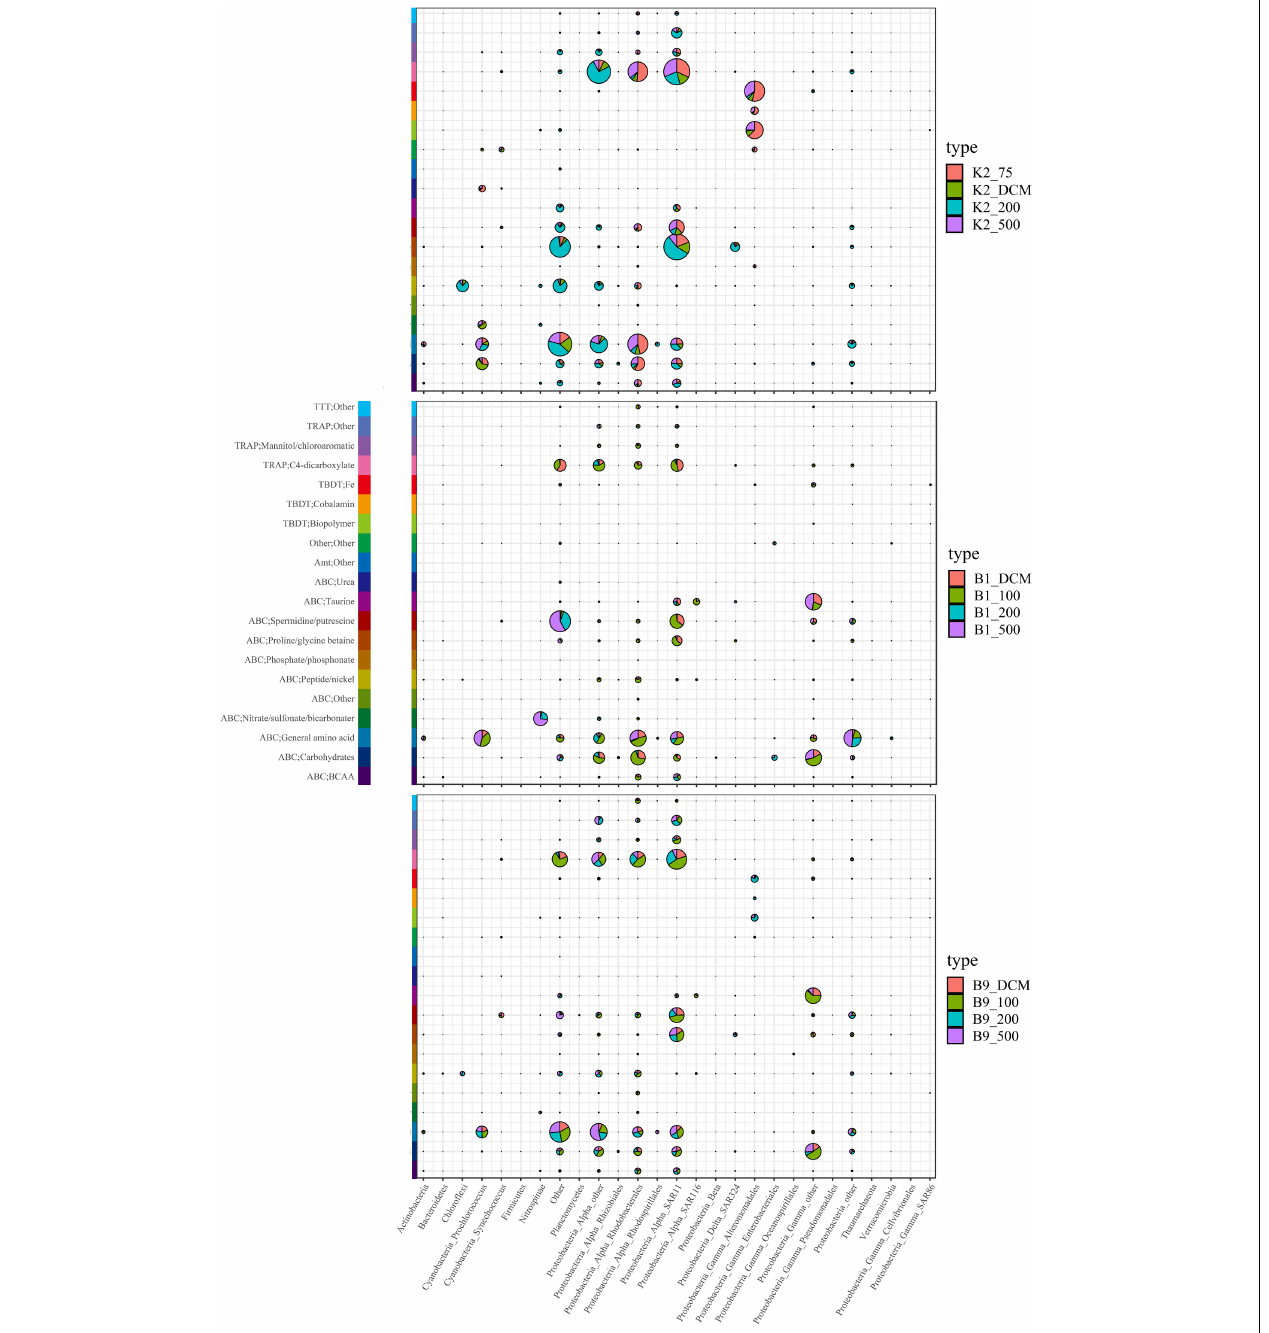
FIGURE 5 | Vertical expression profiles of transporter proteins of abundant taxa. Expression values were calculated in a semiquantitative manner and average abundances were plotted for selected members of the substrate active community residing in the water layers.